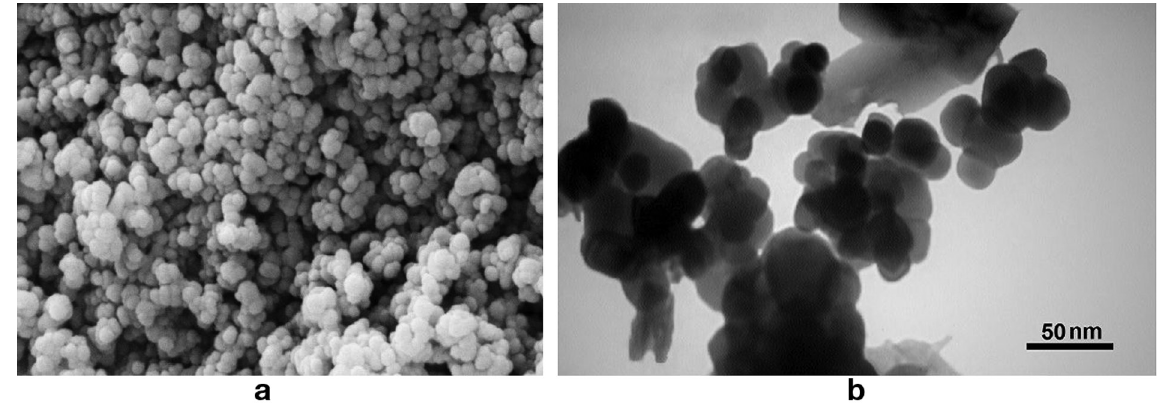
Figure 5: (a) SEM image at high magnification (150x) and (b) TEM micrograph of bio-assisted CuO